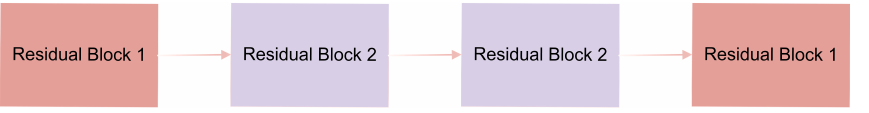
Figure 7. Repeat block structure of model.